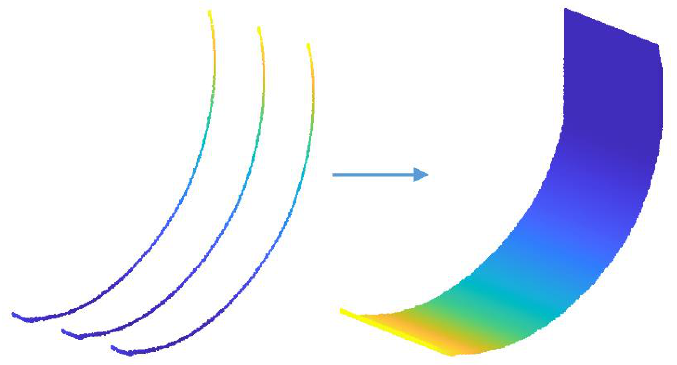
Figure 8. Application of the meshing technique to 2D bucket trajectory.